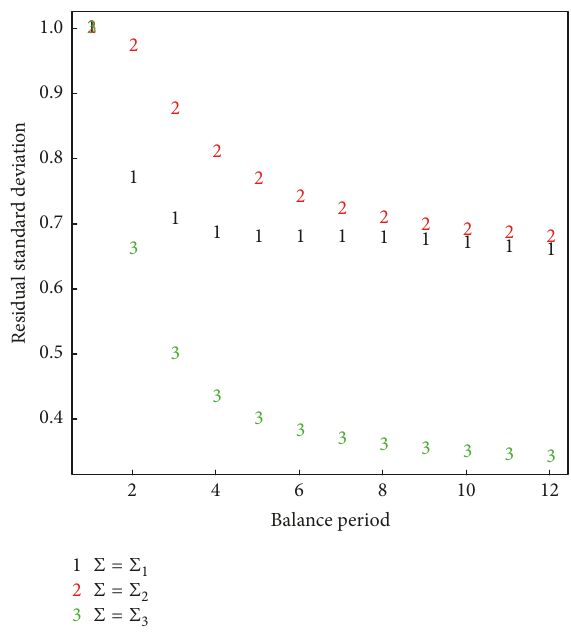
Figure 6: Residual standard deviation ̃𝜎 𝑖 = √𝜎 2 𝑖𝑖 − 𝑓Σ −1 𝑓 𝑇 versus balance period for Σ 1